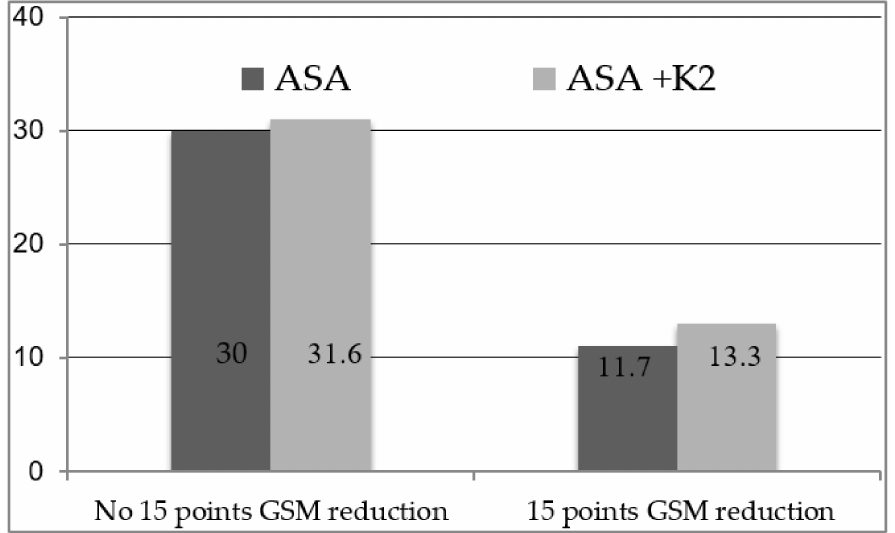
Figure 8. Proportion of subjects with and without a GSM reduction of 15 points at 12